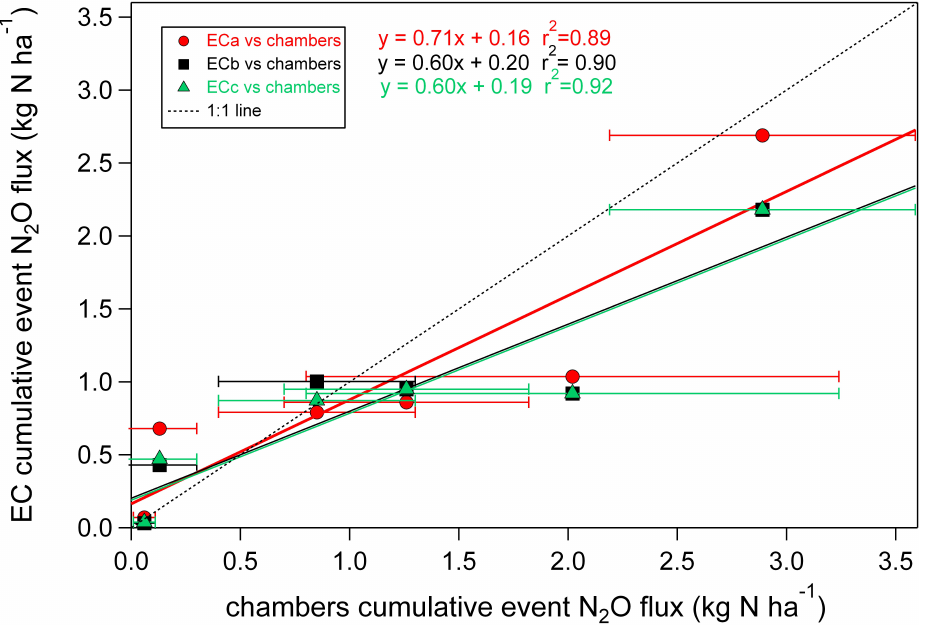
Fig. 4. Comparison of cumulative fluxes from gap-filled data from static chambers and EC, using either comparison points (EC a ) , daily averages (EC b ) or 30min values (EC c )